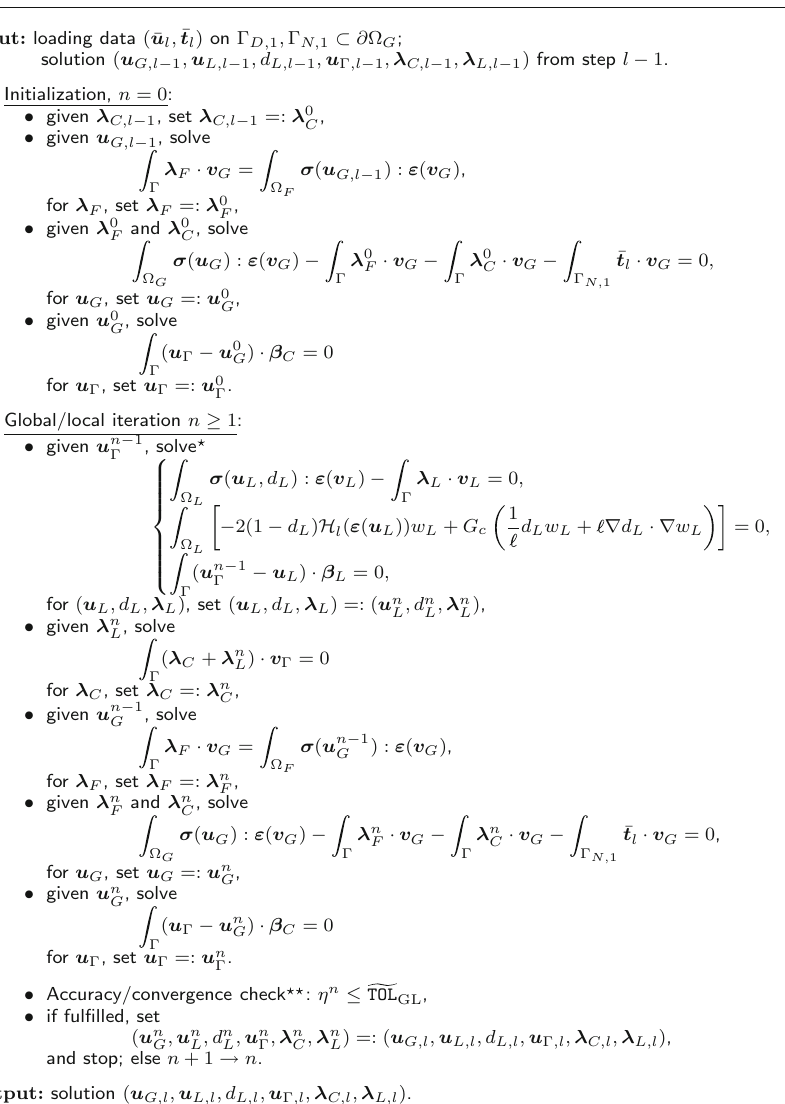
Table 3 Non-intrusive iterative solution process for (G 1 ), (G 2 ), (L), and (C 1 ), (C 2 ), (C 3 ) at a fixed loading step